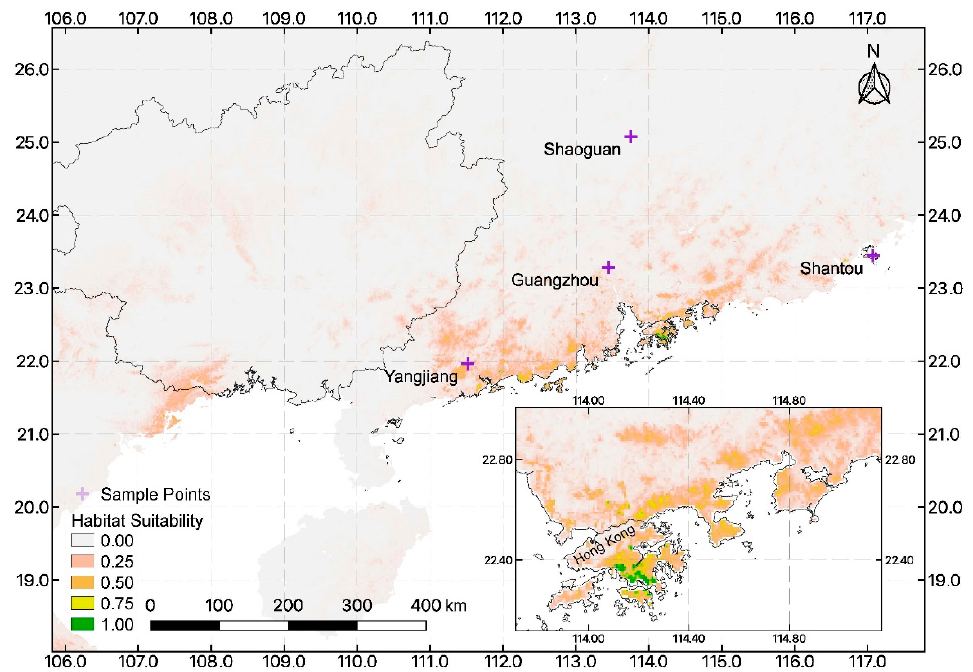
Figure 4. Prediction of habitat suitability for Sphaeropteris lepifera in eastern Asia.